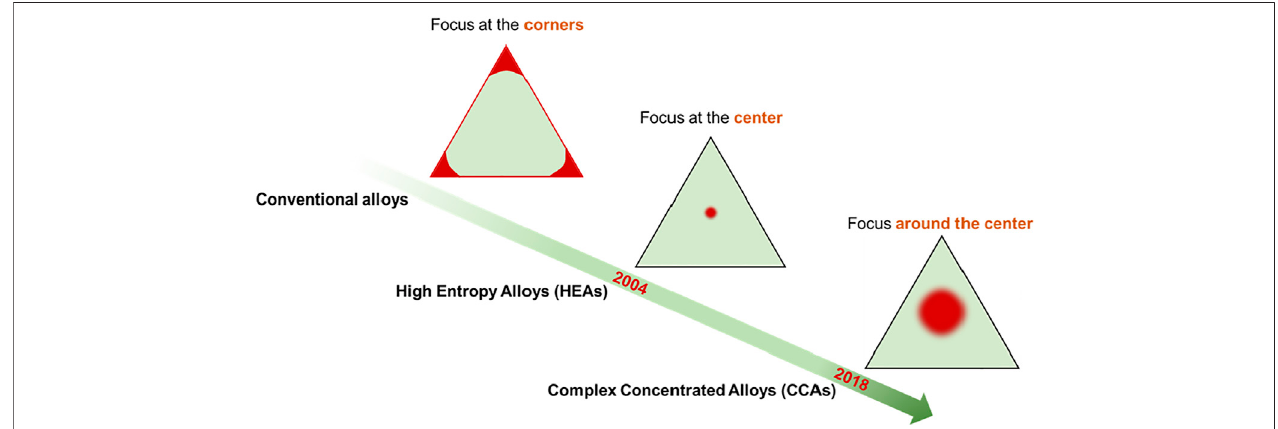
FIGURE 1 | Evolution in high entropy alloy design with